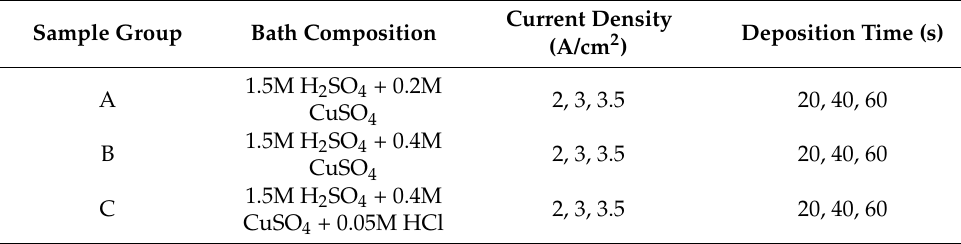
Table 1. Electrodeposition parameters employed for fabrication of the porous Cu electrodes. Sample